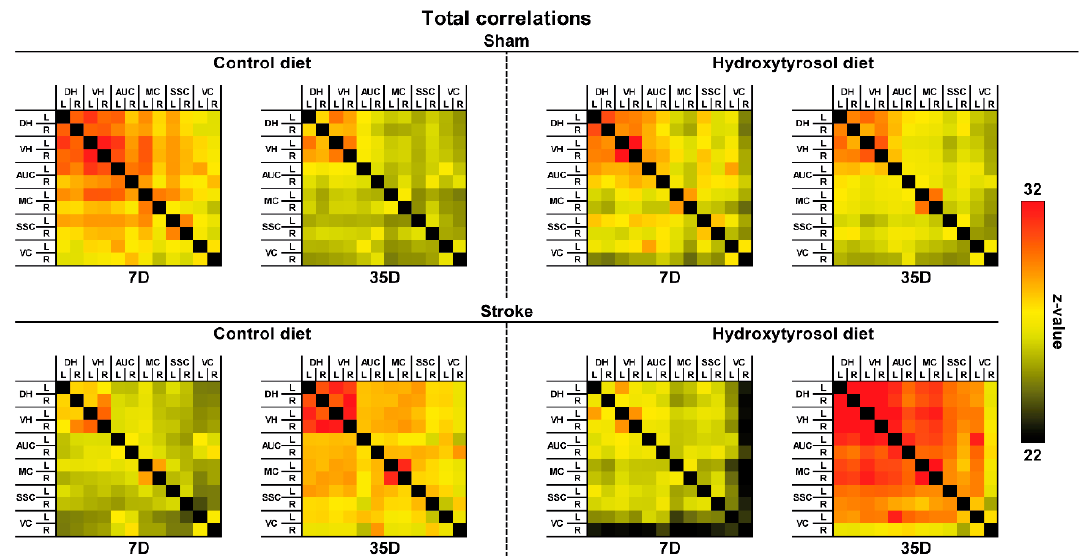
Figure 12. Resting-state functional connectivity (FC) based on total analyses in the brains of mice fed HT or Control diet seven and 35 days post-stroke. FC was measured between 12 ROI: dorsal hippocampus (DH), ventral hippocampus (VH), auditory cortex (AUC), motor cortex (MC), somatosensory cortex (SSC), and visual cortex (VC). Total correlations revealed that HT diet improved FC in stroke mice between several ROI, i.e., right DH to left MC ( p < 0.022); right DH to right M1 ( p < 0.040).